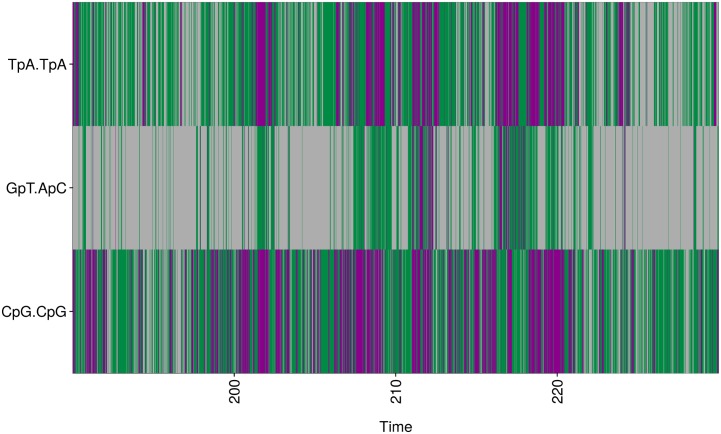
Conformational combinations of facing phosphate linkages illustrated with CHARMM36.In C-MDs, the BII-rich facing phosphate linkages adopt three conformational combinations, BI•BI (grey), BI•BII|BII•BI (green) and BII•BII (violet). The course of these combinations versus time (ns) is illustrated for facing phosphate groups of Oligo 4, two BII-rich steps, C5pG6•C19pG20 and T7pA8•T17pA18, and one BI-rich step, G6pT7•A18pC19. For clarity, only a small part of the trajectory is shown here.